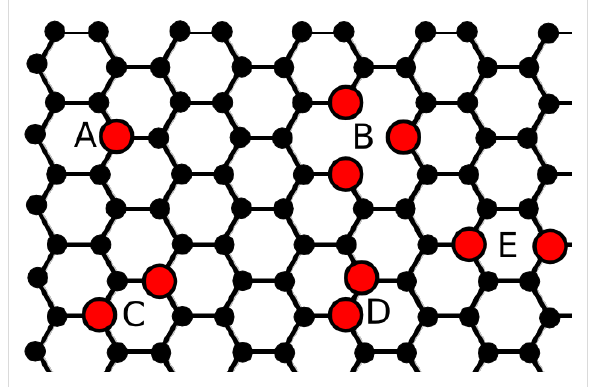
Figure 1: Schematic of a graphene lattice with the most common experimentally observed species of substitutional nitrogen dopants: (A) a single graphitic, (B) three pyridinics, (C) one N 2AA pair, (D) one N 2AB pair and (E) one N 2AB ′